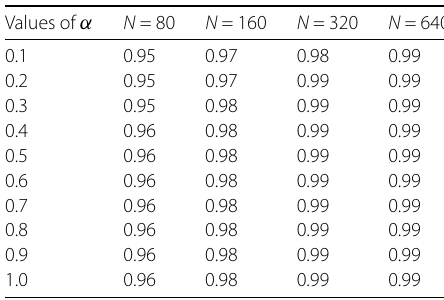
Table 4 Rates of convergence for Example 5.2 with r = 0.065 and δ = 0.045 Values of